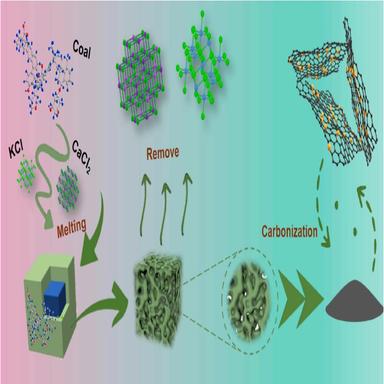
Schematic diagram of CHC preparation.